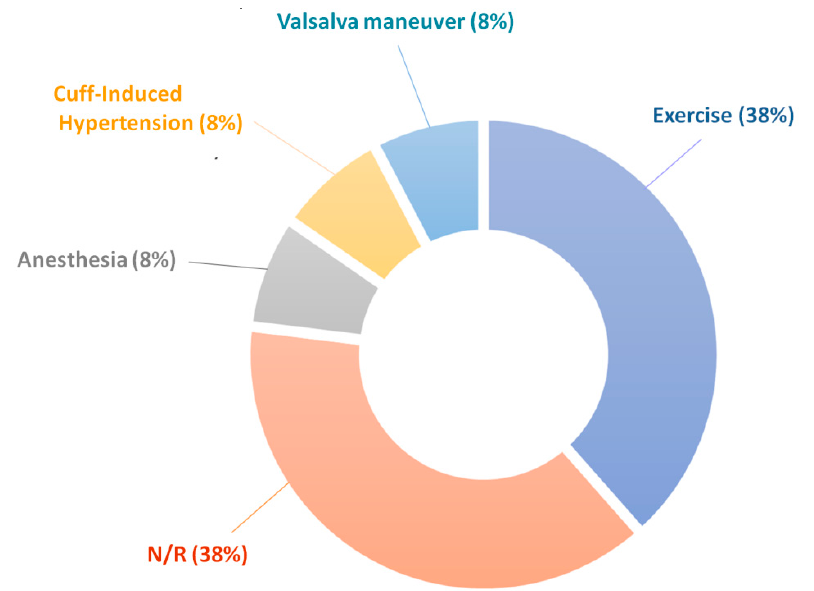
Figure 6. A representation of the methods used in the studies to provoke changes in blood pressure during validation of the multi-site PPG technique. Exercise = stationary calf raises, hand grip exercise, or physical activity immediately before measurement; anesthesia = general anesthesia; cuff-induced hypertension = BP cuff used to occlude the brachial artery to artificially raise the BP in the carotid; Valsalva maneuver = exhaling against a closed glottis; N/R = not